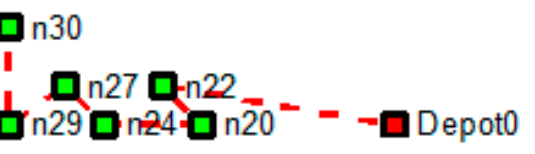
Figure 6. New partial route of route 2.